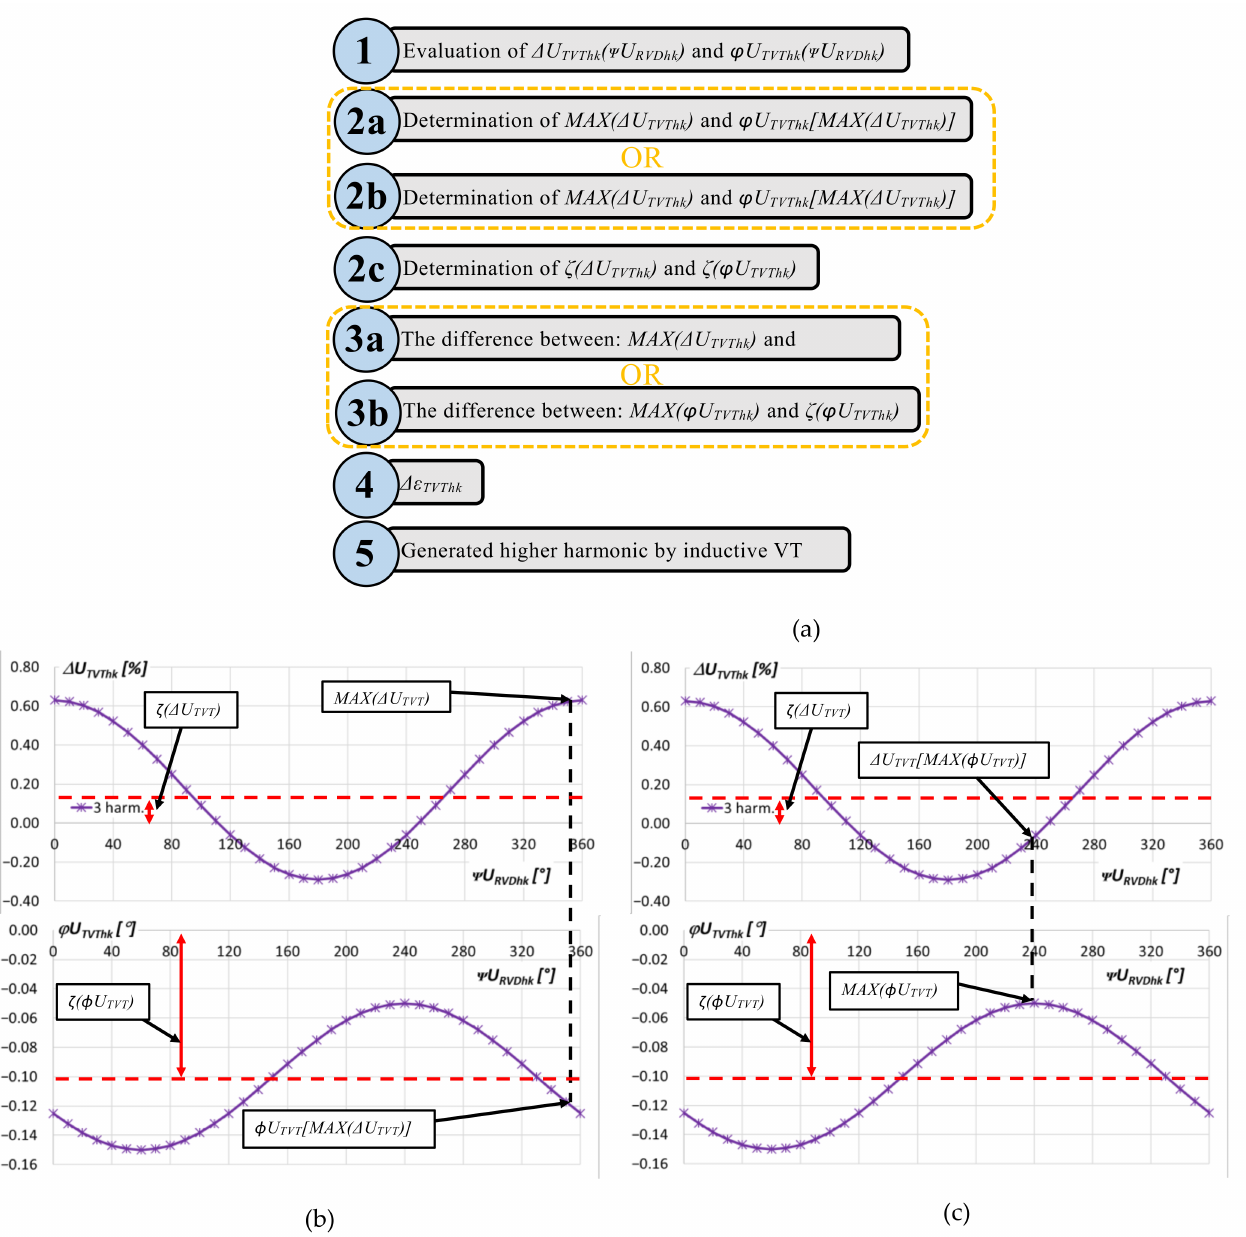
Figure 7. The method to calculate the values of the low order higher harmonics self-generated to the secondary voltage of the inductive VT: ( a ) flow chart, ( b ) the approach with the maximum value of voltage error ( c ) the approach with the maximum value of phase